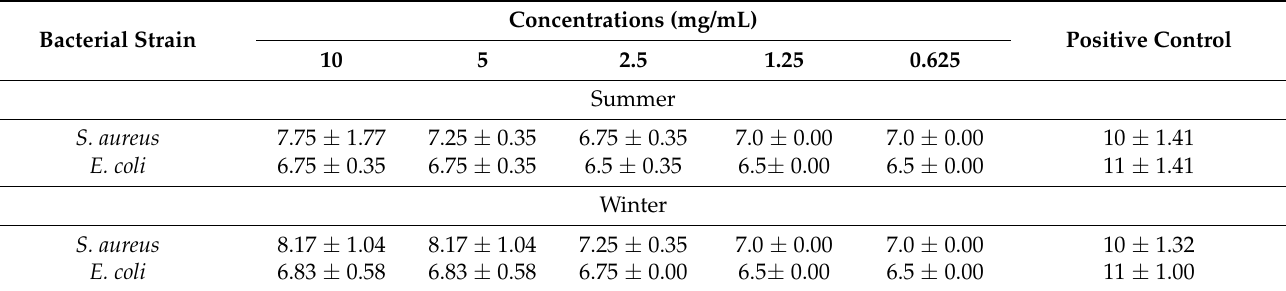
Table 3. Means and standard deviations of the zones of inhibition (mm) of the methanol extract of C. macrocarpa leaves (summer and winter) at different concentrations